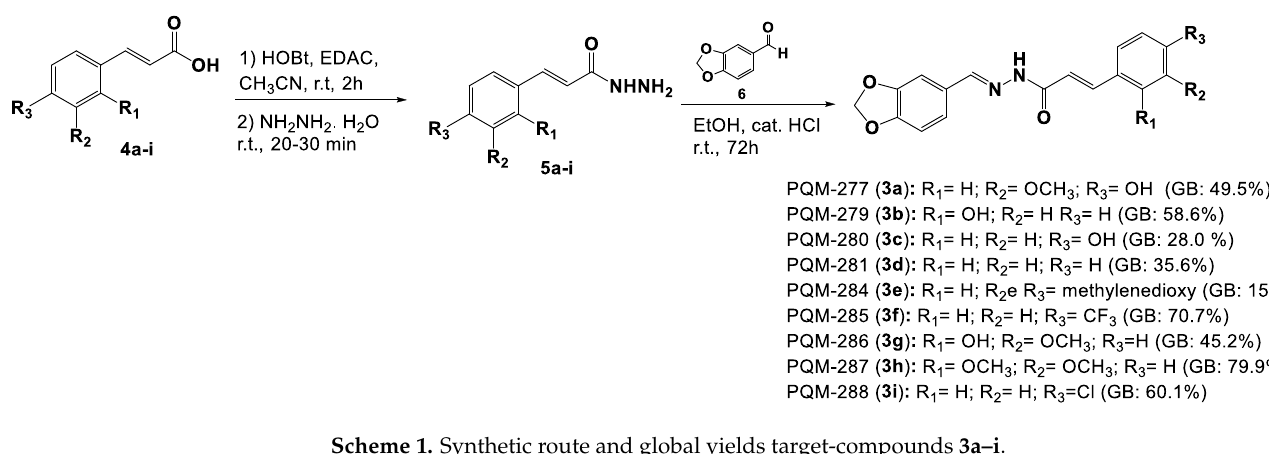
Figure 1. Design of new piperine – chlorogenic acid acylhydrazone hybrid series 3 by molecular hy- bridization of structural fragments from piperine ( 1 ) and chlorogenic acid ( 2 , CGA) connected by an acylhydrazone subunit. conjugated benzo[d]1,3-dioxole moiety from the piperine ( 1 ); cinnamoyl fragment from chlorogenic acid ( 2 ); acylhydrazone spacer